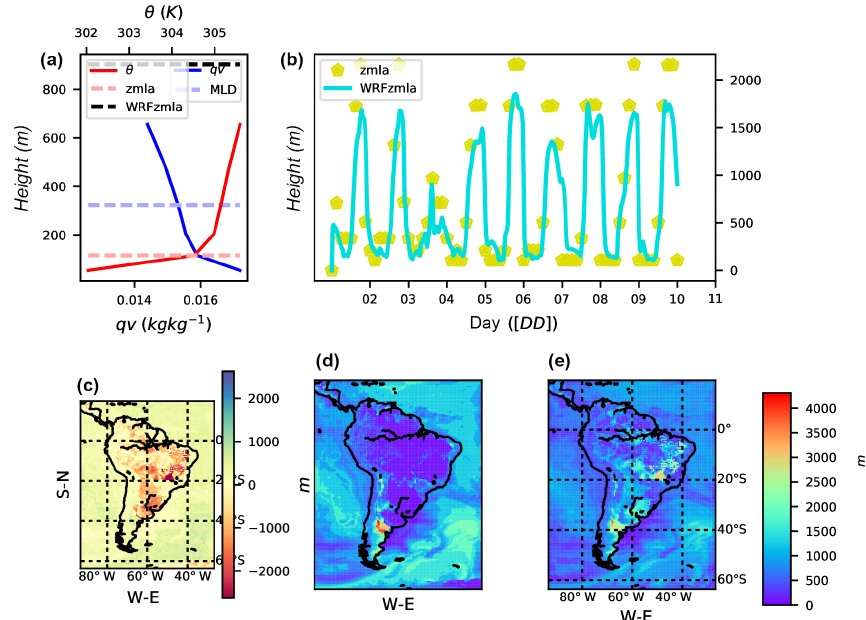
Figure 9. Vertical characteristics of the atmosphere on 9 December 2012 at 15:00UTC at 62 ◦ 4 (cid:48) 38.00 (cid:48)(cid:48) S, 4 ◦ 58 (cid:48) 55.51 (cid:48)(cid:48) W. (a) Potential temperature vertical profile ( θ K, red line), vertical profile of mixing ratio (qv kgkg − 1 , blue line), mixed-layer depth (MLD, dashed hori- zontal line at 323.522m), derived boundary layer height (zmla, horizontal dashed line at 1007.122m), and WRF-derived PBL scheme value (WRF zmla at 903.017m). Comparison of temporal evolutions (b) between derived zmla (yellow stars) and WRF’s PBL scheme (blue line). Map of differences between derived and WRF simulated (zmla − zmla WRF , c ), zmla map (d) , and zmla WRF (e)